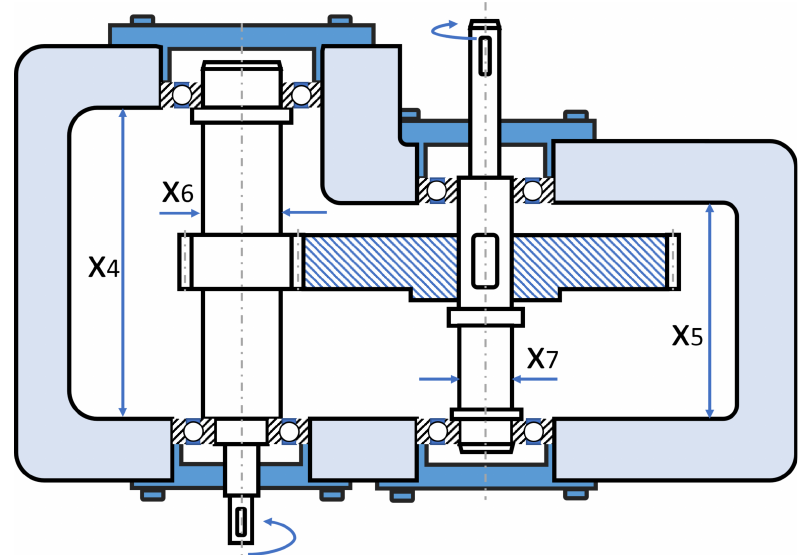
Figure 5. Schematic view of the reduction gear design problem.